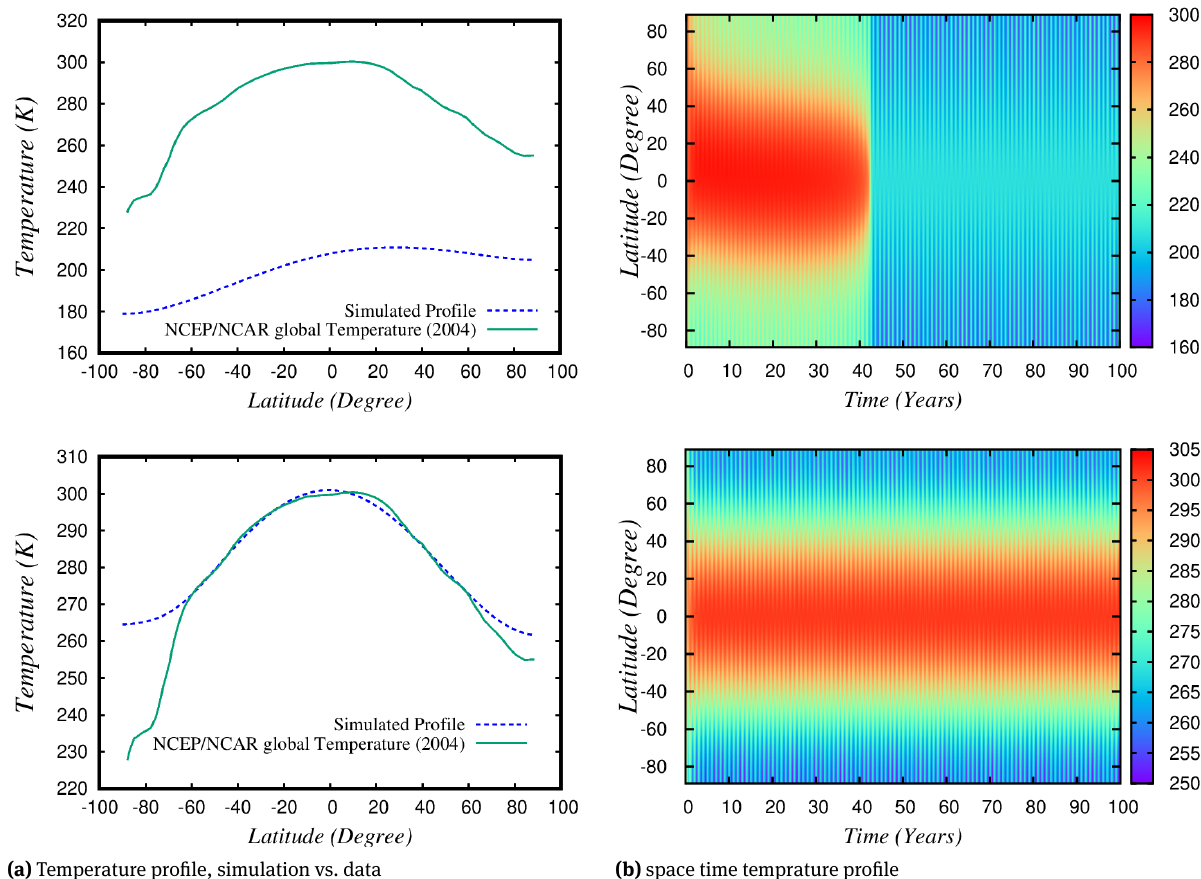
Figure A1. Dependence on initial orbital position. Top row: Global freezing occurred when the simulation started at northern solstice using albedo in Spiegel et al. (2009). Bottom row: No global freezing happened when the simulation started at northern solstice using albedo in equation